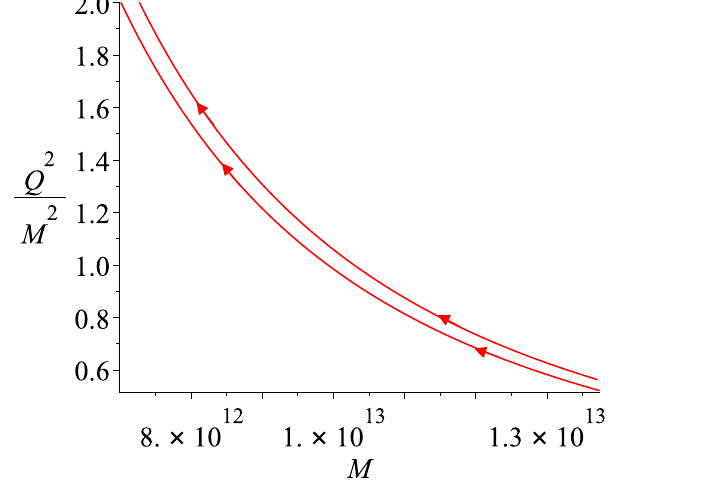
Figure 3 . Examples of GHS black holes that evolve towards extremality ( Q 2 =M 2 = 2) with Hiscock-Weems model. Parts of these curves are the same ones that appear in (cid:12)gure